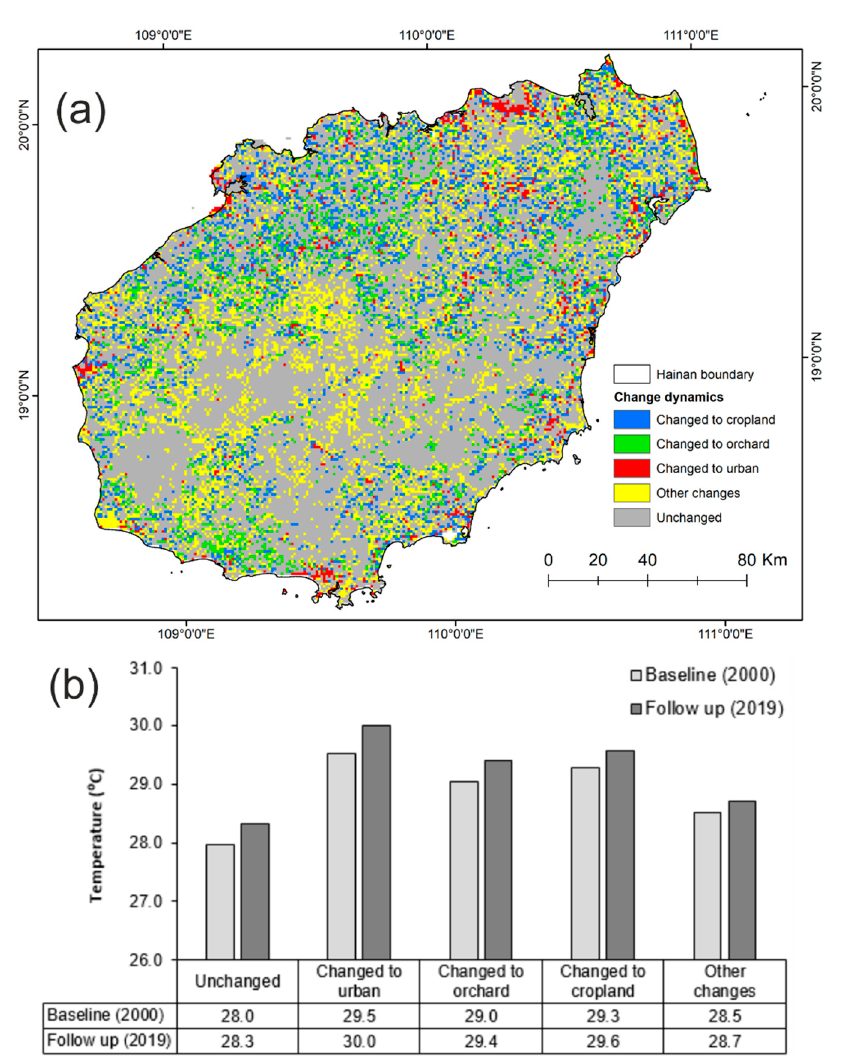
Figure 12. Land cover matrix dynamics and LST changes: (( a ) The land cover matrix dynamics; ( b ) The LST changes on the di ff erent land cover transformation).